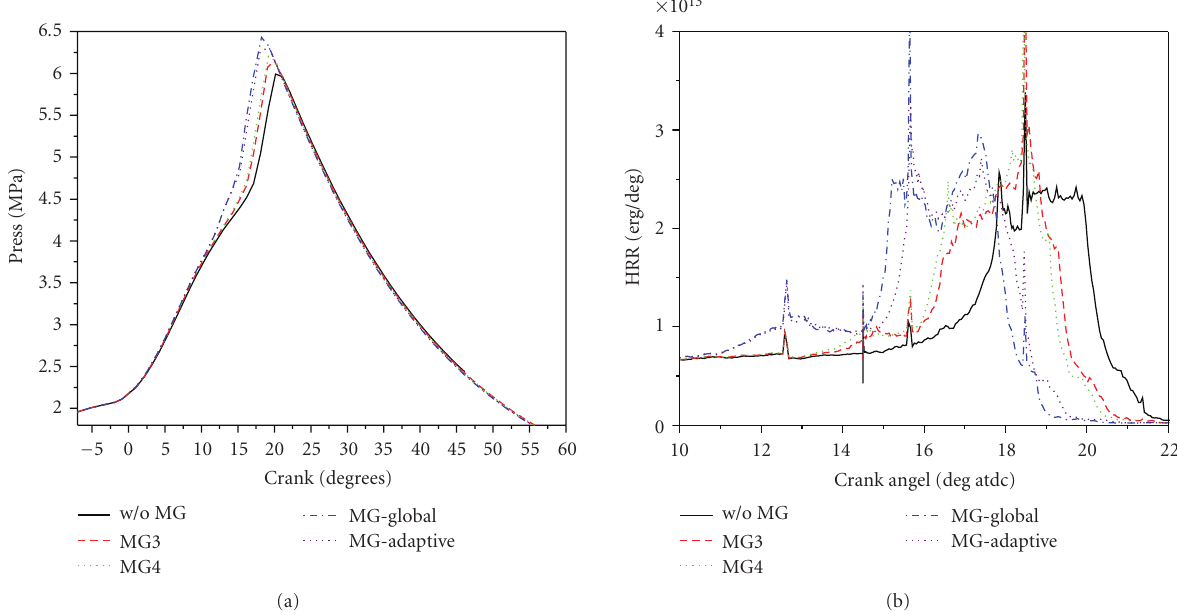
Figure 4: Pressure and HRR of SI engine simulated using one-zone MG model with di ff erent searching levels.